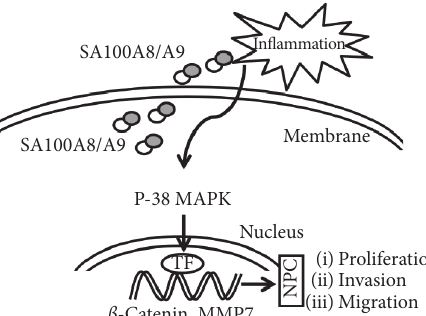
Figure 5: A hypothesis for the association between SA100A8/A9 proteins and